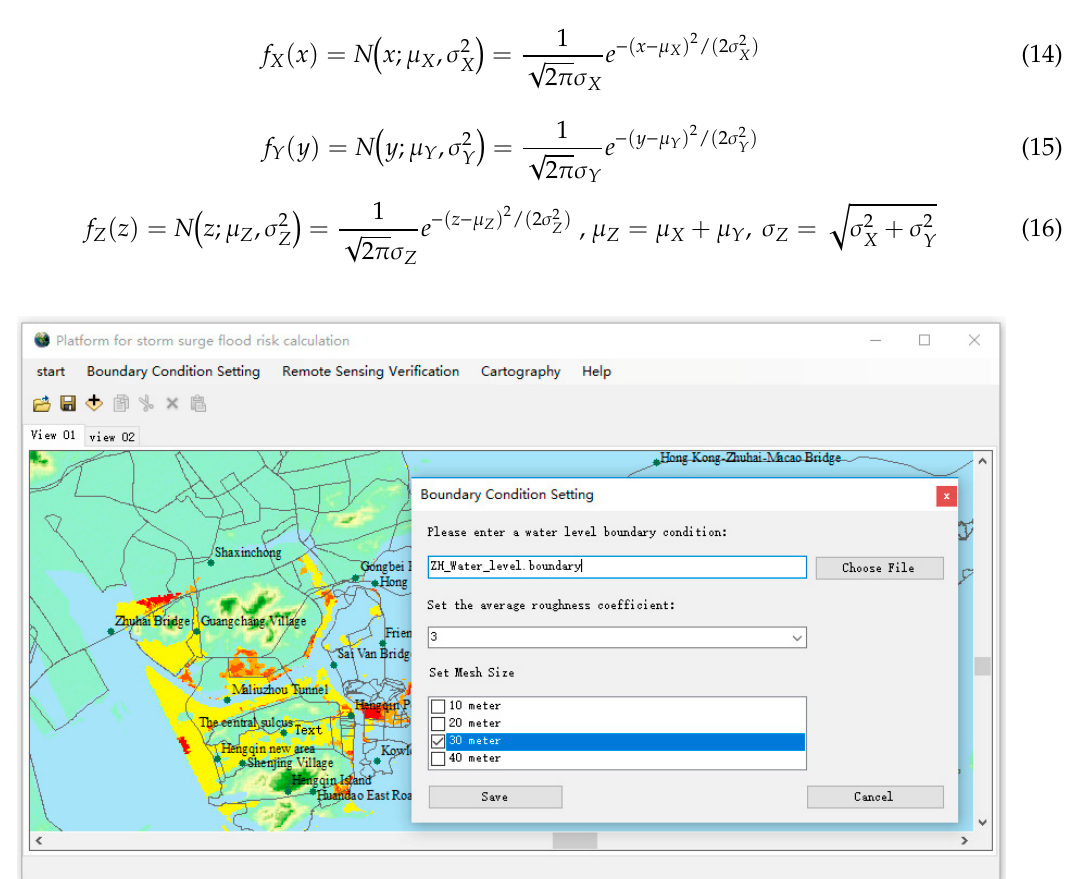
Figure 13. Distribution of flood disaster losses map on the platform interface.